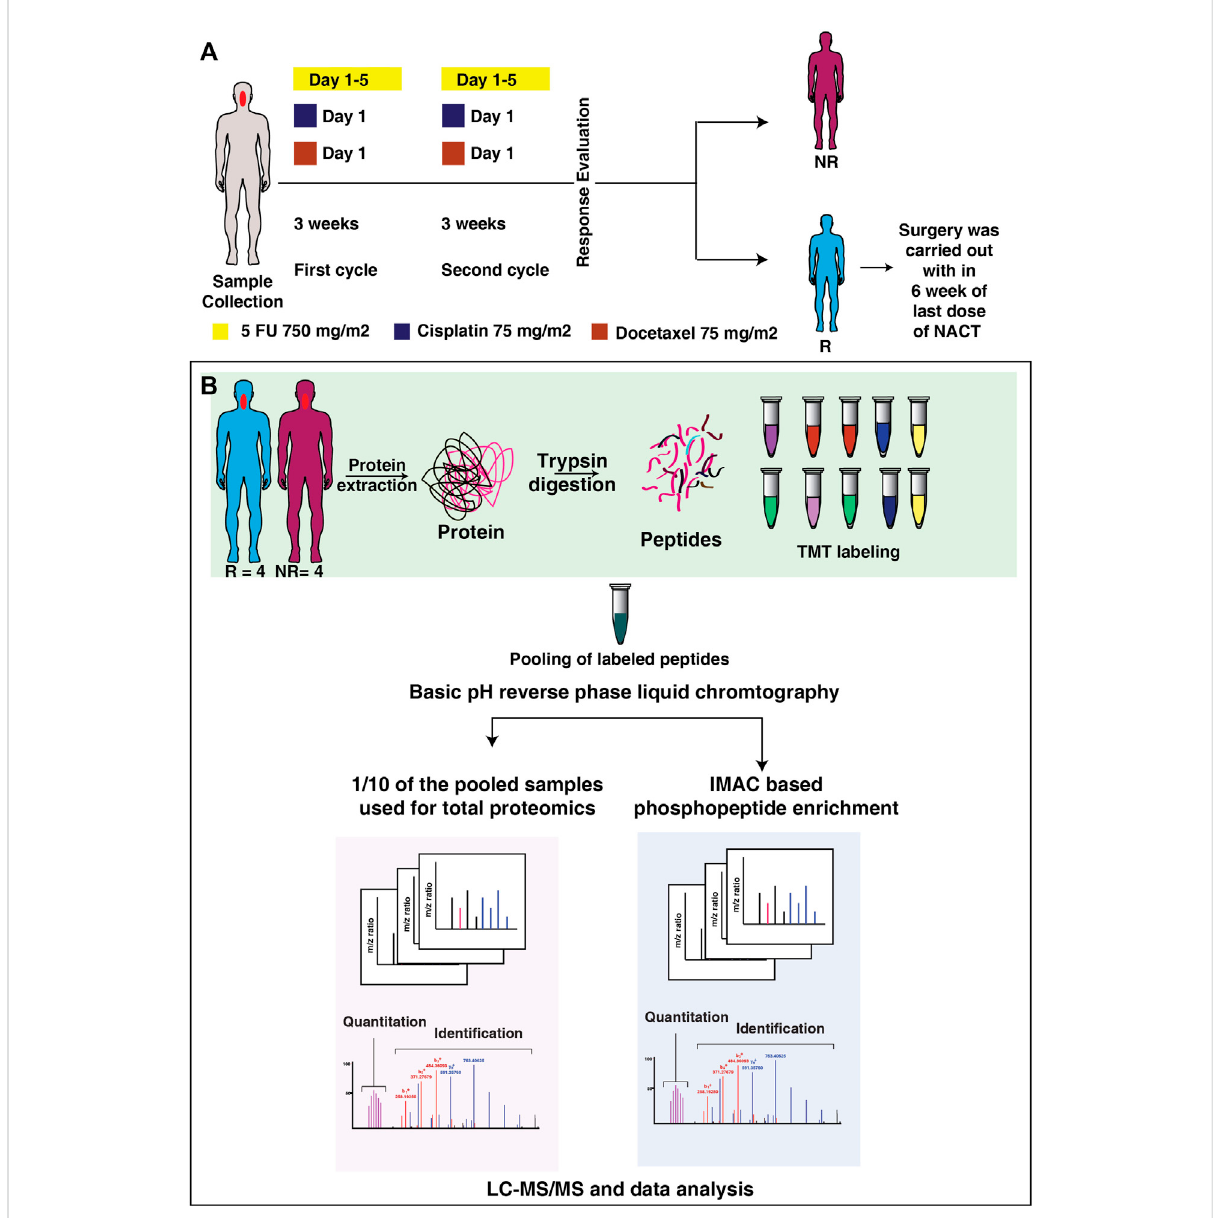
FIGURE 1 Treatment timeline and the work fl ow applied in integrated proteomic and phosphoproteomics of NACT resistant and sensitive TSCC patients. (A) Thetimelineofthetissuecollectionandtreatmentgiventothepatient.Tissuebiopsysampleswerecollectedfromthepatientpriortothestartof therapy. All the patients were treated with DCF, or DC based neoadjuvant chemotherapy. After two cycle of treatment patients were classi fi ed as resistant or sensitive according to RECIST criteria. (B) Work fl ow applied for integrated proteomic and phosphoproteomics of NACT